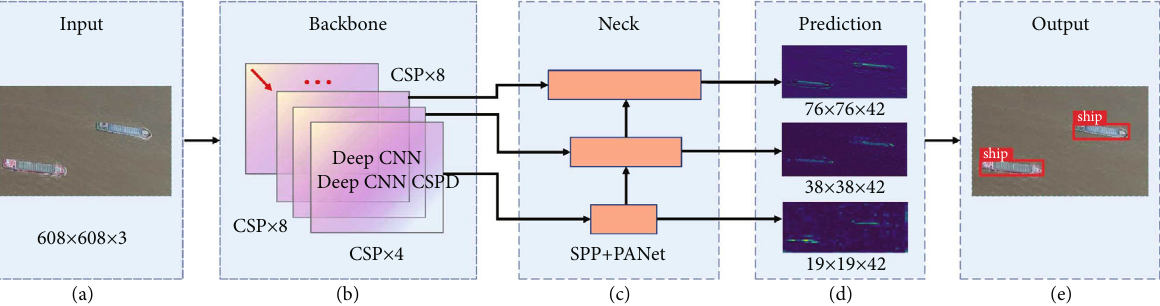
Figure 2: Schematic diagram of ship detection.